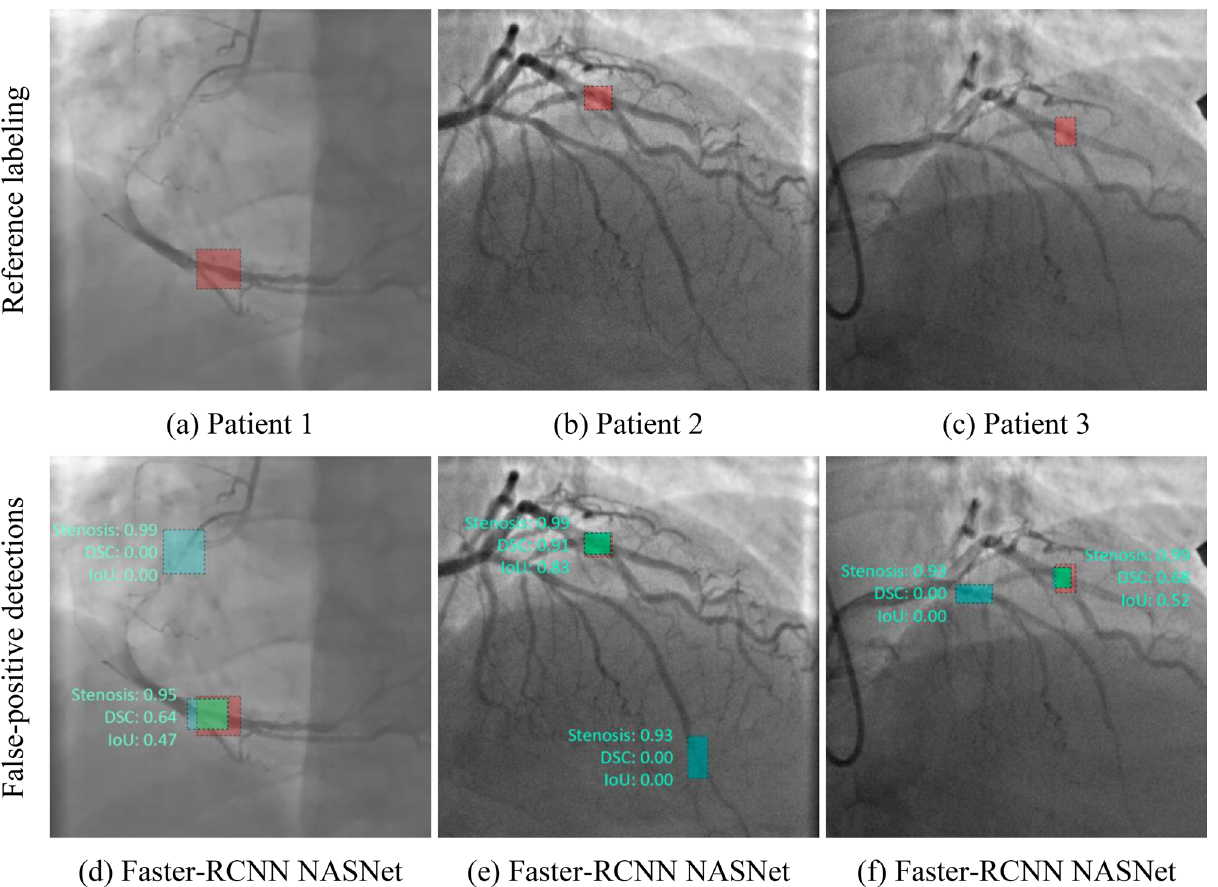
Figure 9. Example of the false positive predictions obtained using Faster-RCNN NASNet neural network for three test patients with the referenced labelling.